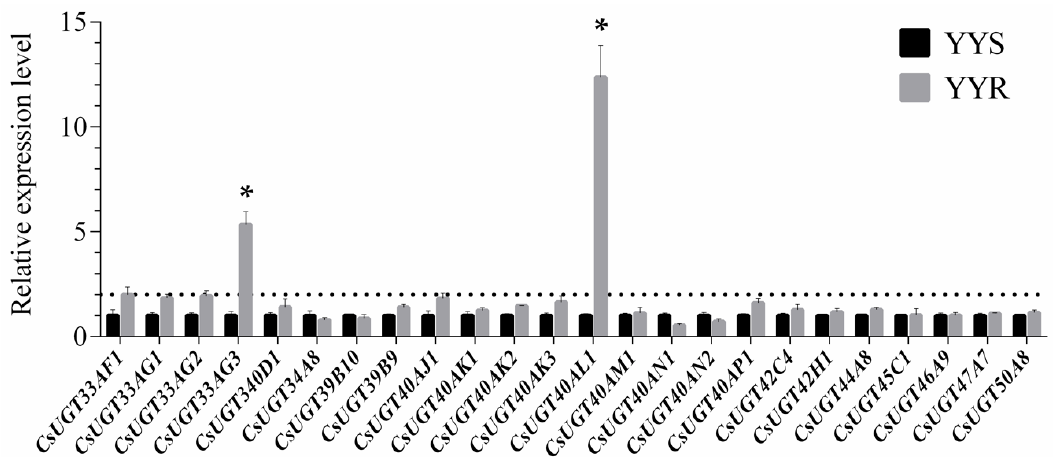
Figure 3. Relative expression levels of UGTs in YYS and YYR determined by real-time quantitative reverse transcription polymerase chain reaction (qRT-PCR). Data were normalized to the expression of G3PDH and Actin A1 . Error bars represent the standard deviation (SD) from the mean of three independent replicates. Thirty fourth instar larvae were sampled for each biological replicate. Asterisks ( * ) indicate a significant difference in the expression levels of UGTs between YYS and YYR using Student’s t -test ( p < 0.05).